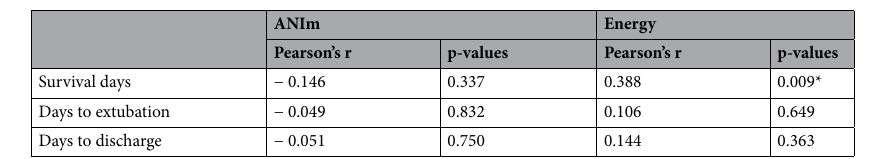
Table 2. Correlation between prognostic variables with ANIm and Energy between groups. Pearson’s correlation coefficient and HRV variables for each group; ANIm, mean analgesia nociception index. *Significance defined as p-value < 0.05.